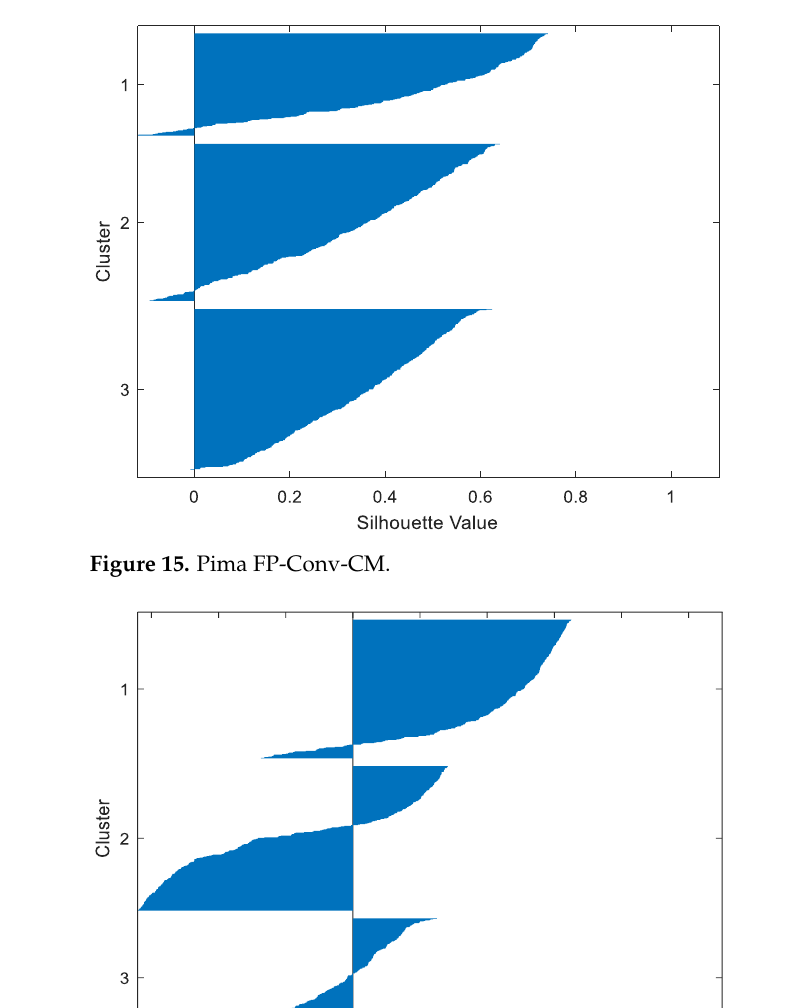
Figure 14. Abalone GMM.